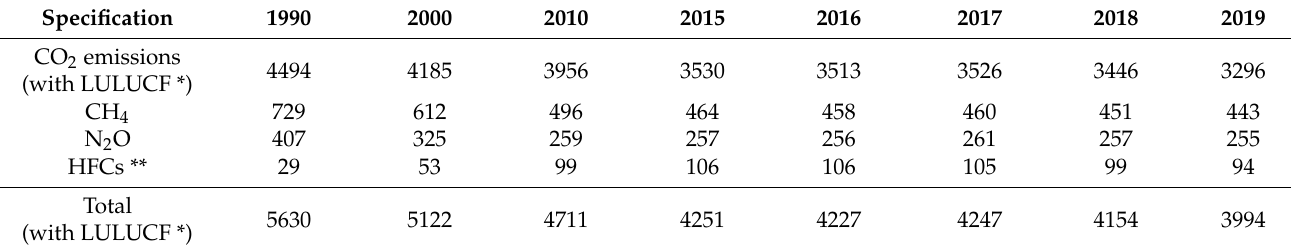
Table 4. Overview of emissions and removals of the EU’s main greenhouse gases 1990–2019 in million tons of CO 2 [32]. Specification